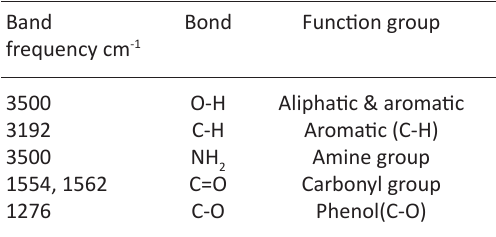
Table 4. Solubility of alkaloid compound extracted from Myristica fragrans Chloroforme Alkaloid